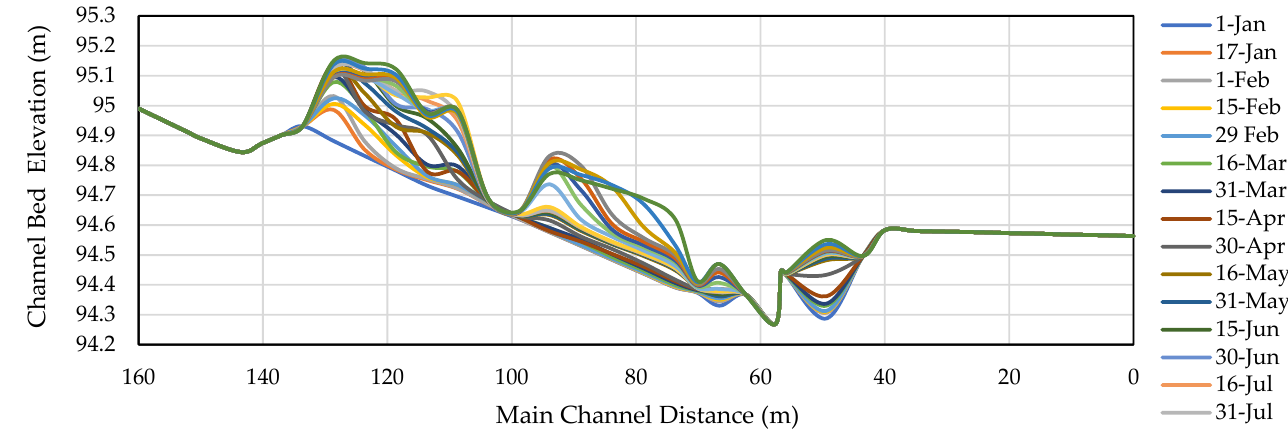
Figure 15. The bi-weekly bed configuration along the sand trap due to the incoming sediment during the operational period. The values are presented every two weeks according to the irrigation requirement discharge settings in the Pengasih irrigation scheme.